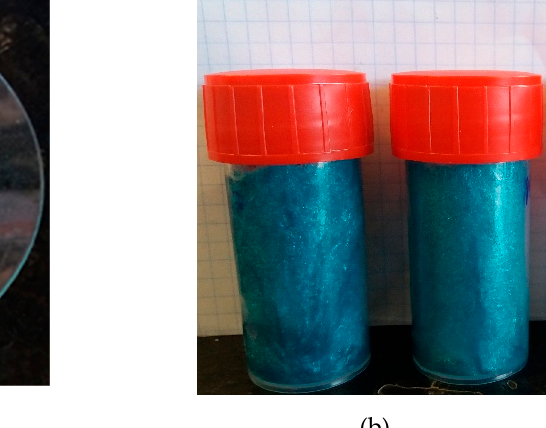
Table 3. List of samples under